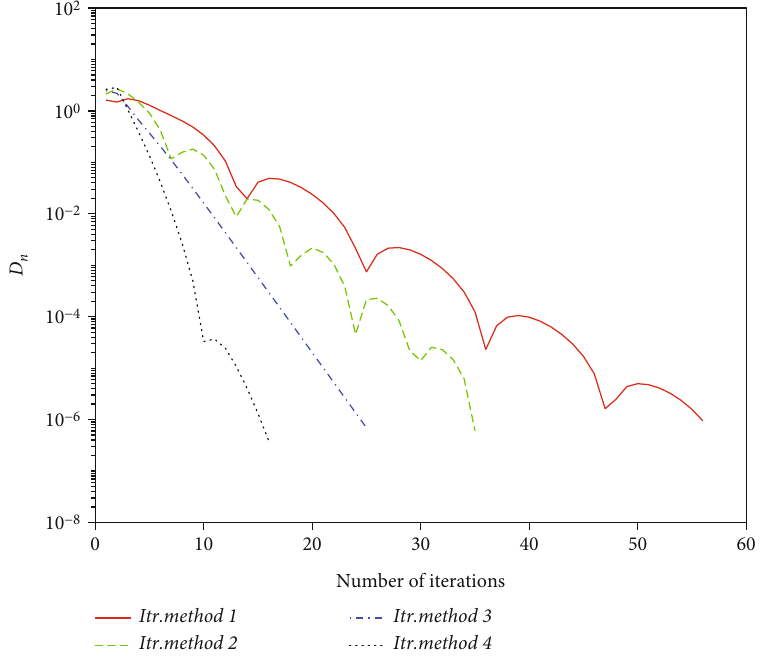
Figure 5: All methods are compared computationally while x